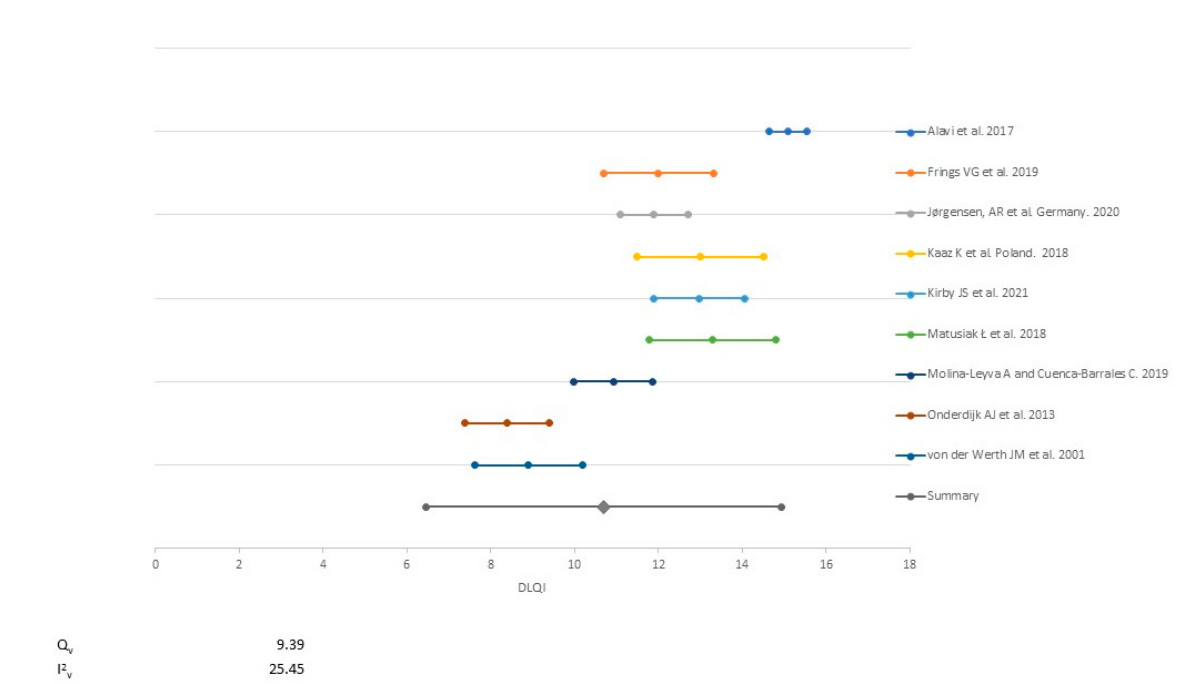
Figure 1. Flow chart of the studies included.